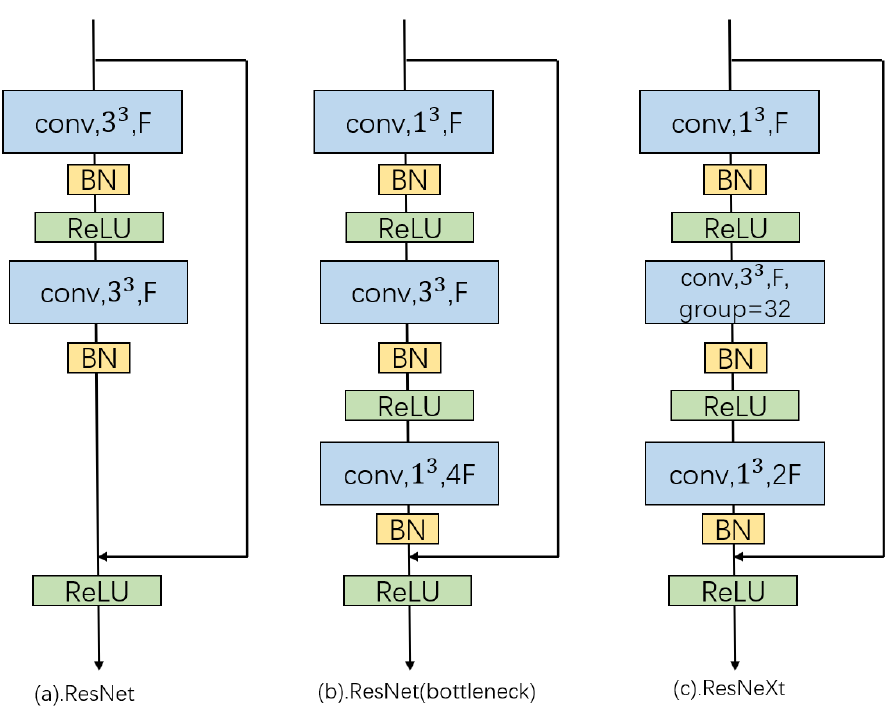
Figure 6. Block of each architecture. conv and 3 3 denote a 3 × 3 × 3 convolutional filter, while F and group is the number of feature channels and groups of group convolution,